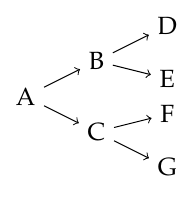
Figure 1. Path dependency illustrated in a simple graph; travel between points only moves in one direction (toward the future), after which previously accessible points (alternate futures) are longer